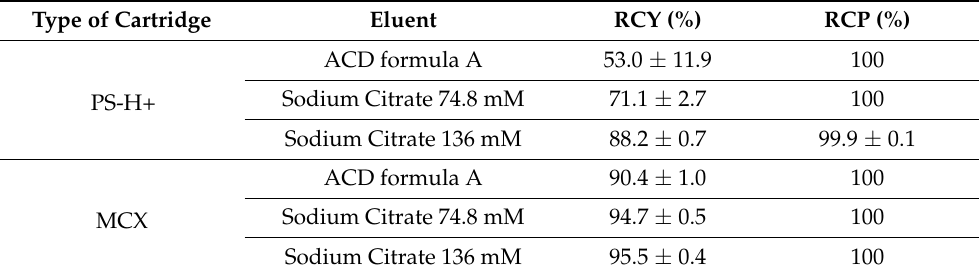
Table 2. Influence of the eluent solution on the radiochemical yield using two types of solid support (PS-H+ and MCX). Volume of eluant was fixed at 4 mL ( n = 3). Type of Cartridge Eluent RCY (%) RCP (%) ACD formula A 53.0 ± PS-H+